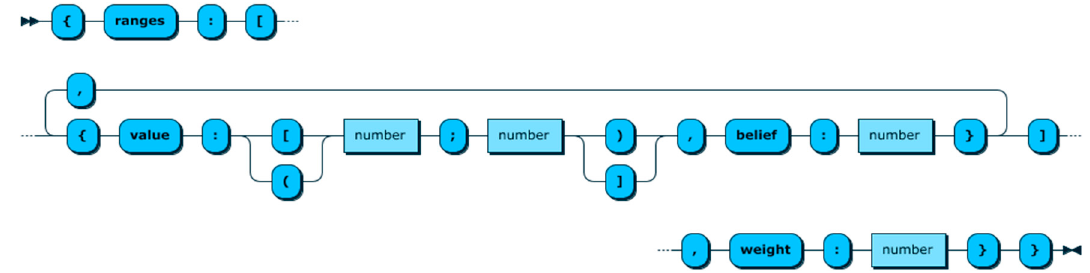
Figure 20. CST-ATTRIBUTE-DEFINITION.